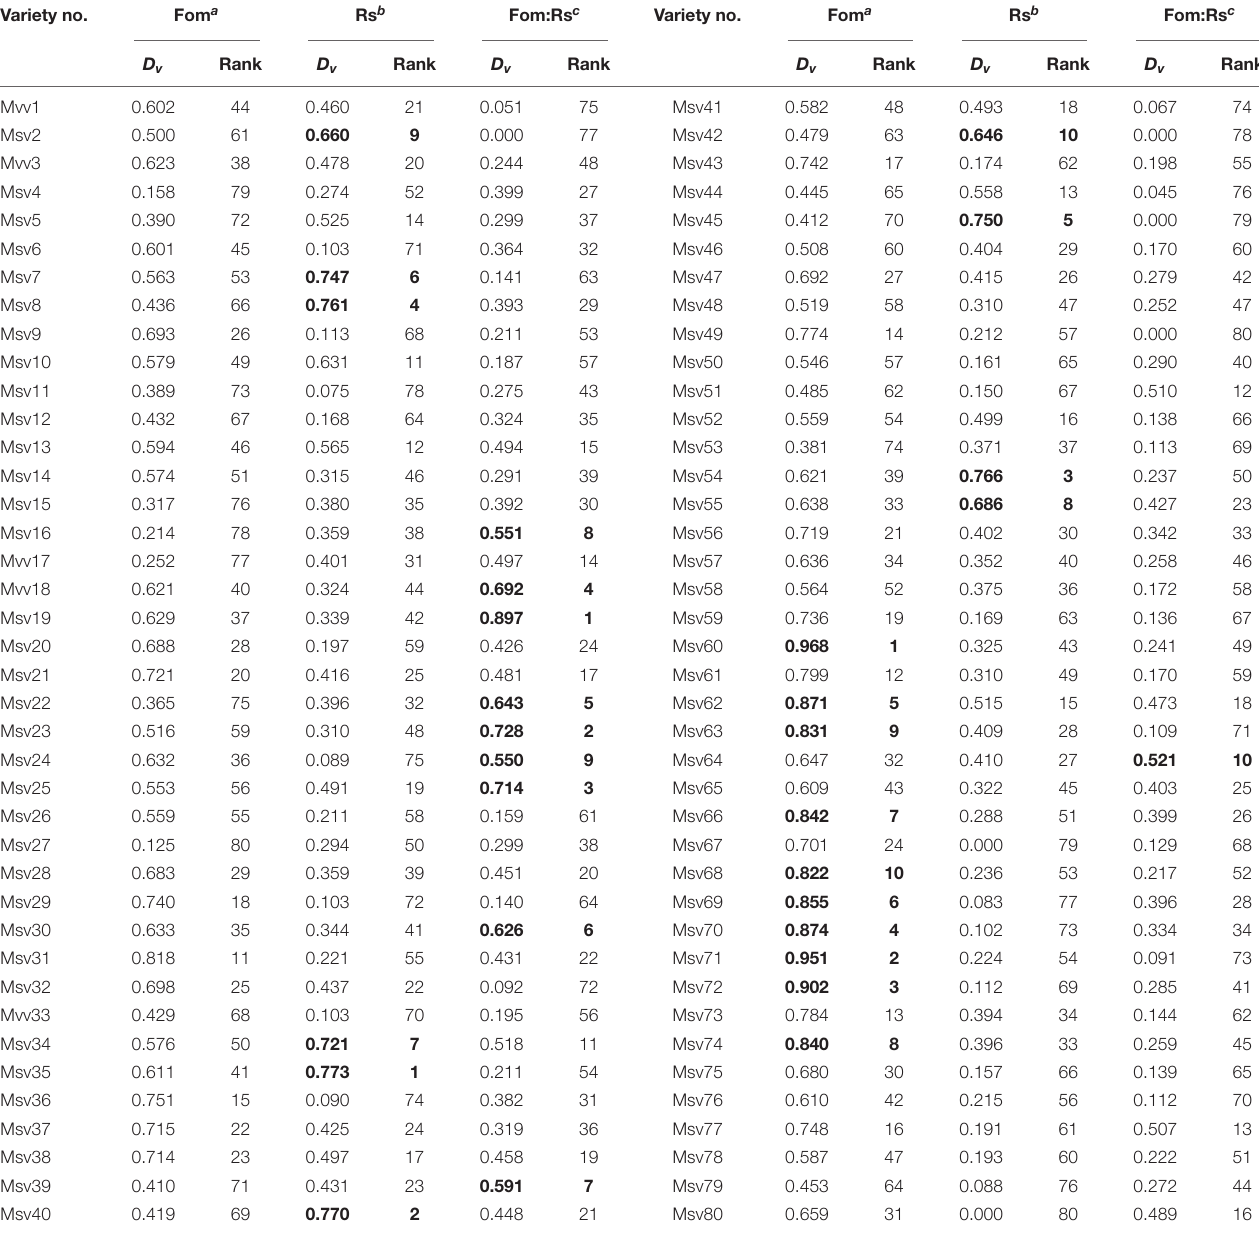
TABLE 1 | Comprehensive resistance ranking of the 80 alfalfa varieties to Fom and Rs under either single or co-infection based on the membership function value ( D v ). Variety no. Fom a Rs b Fom:Rs c Variety no. Fom a Rs b Fom:Rs